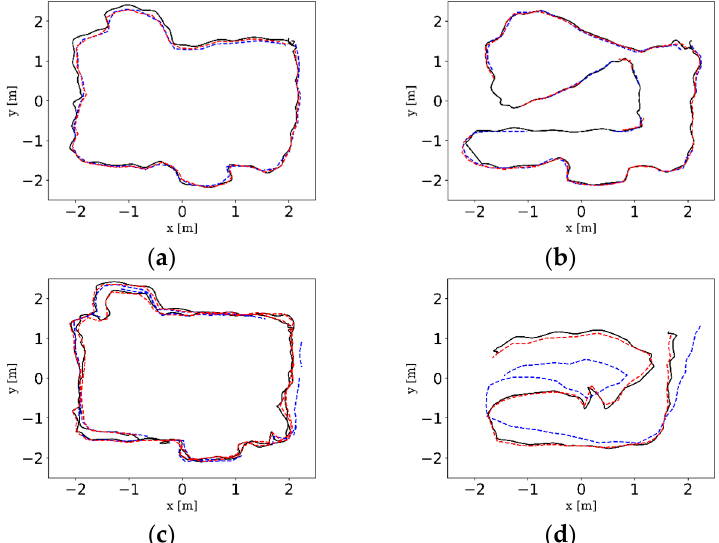
Figure 17. The estimated trajectories of VINS-MKF (Red dotted line), VO-MKF (Blue dotted line) and the ground truth (Black solid line) on different datasets. ( a ) dyn_1_squ; ( b ) dyn_1_arb; ( c ) dyn_2_static; ( d ) dyn_2_arb.